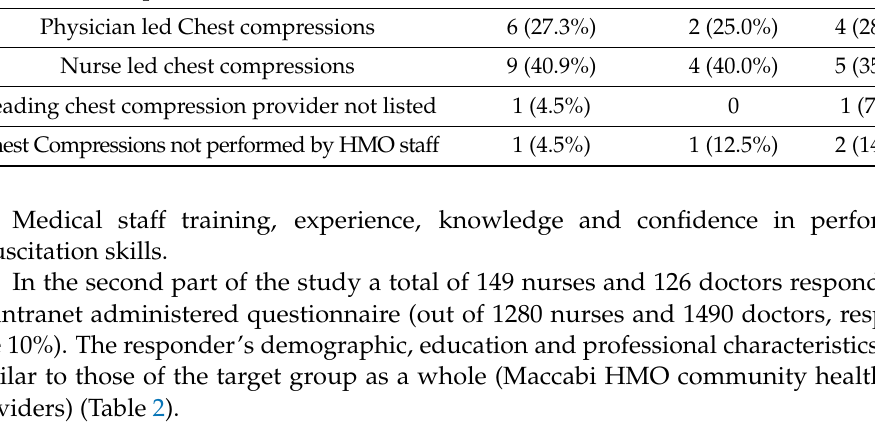
Table 2. Demographic characteristics of respondents ( n = 275) and target group ( n =